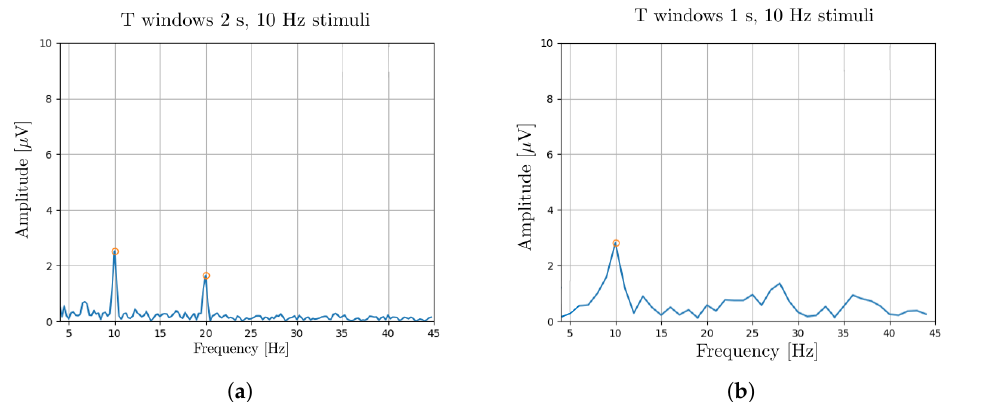
Figure 7. FFT analysis of SSVEP response for a 10 Hz visual stimulus. ( a ) Time window 2 s. ( b ) Time window 1